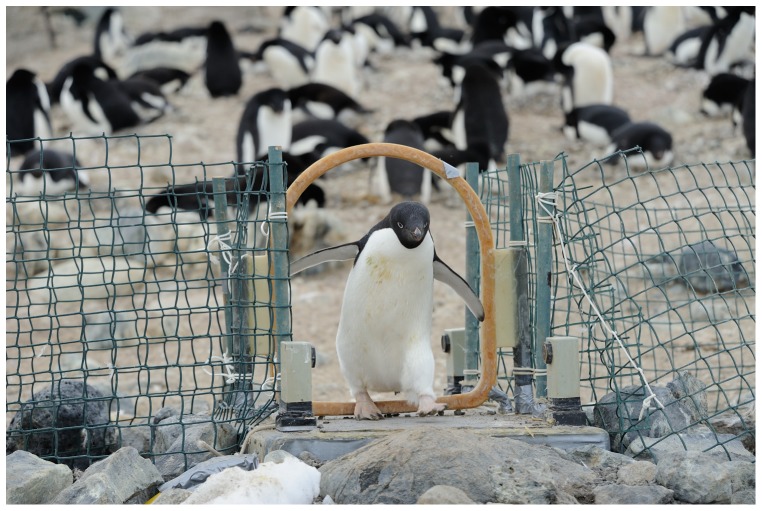
Adélie penguins are identified and weighed each time they cross the automated weighbridge on their way to/from the sea.Picture from David Grémillet.